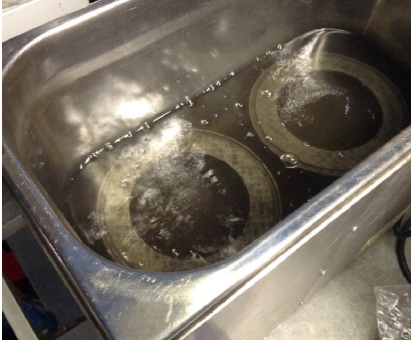
Figure 2. An image of degreasing SLM-processed blade tooling with acetone in an ultrasonic bath.